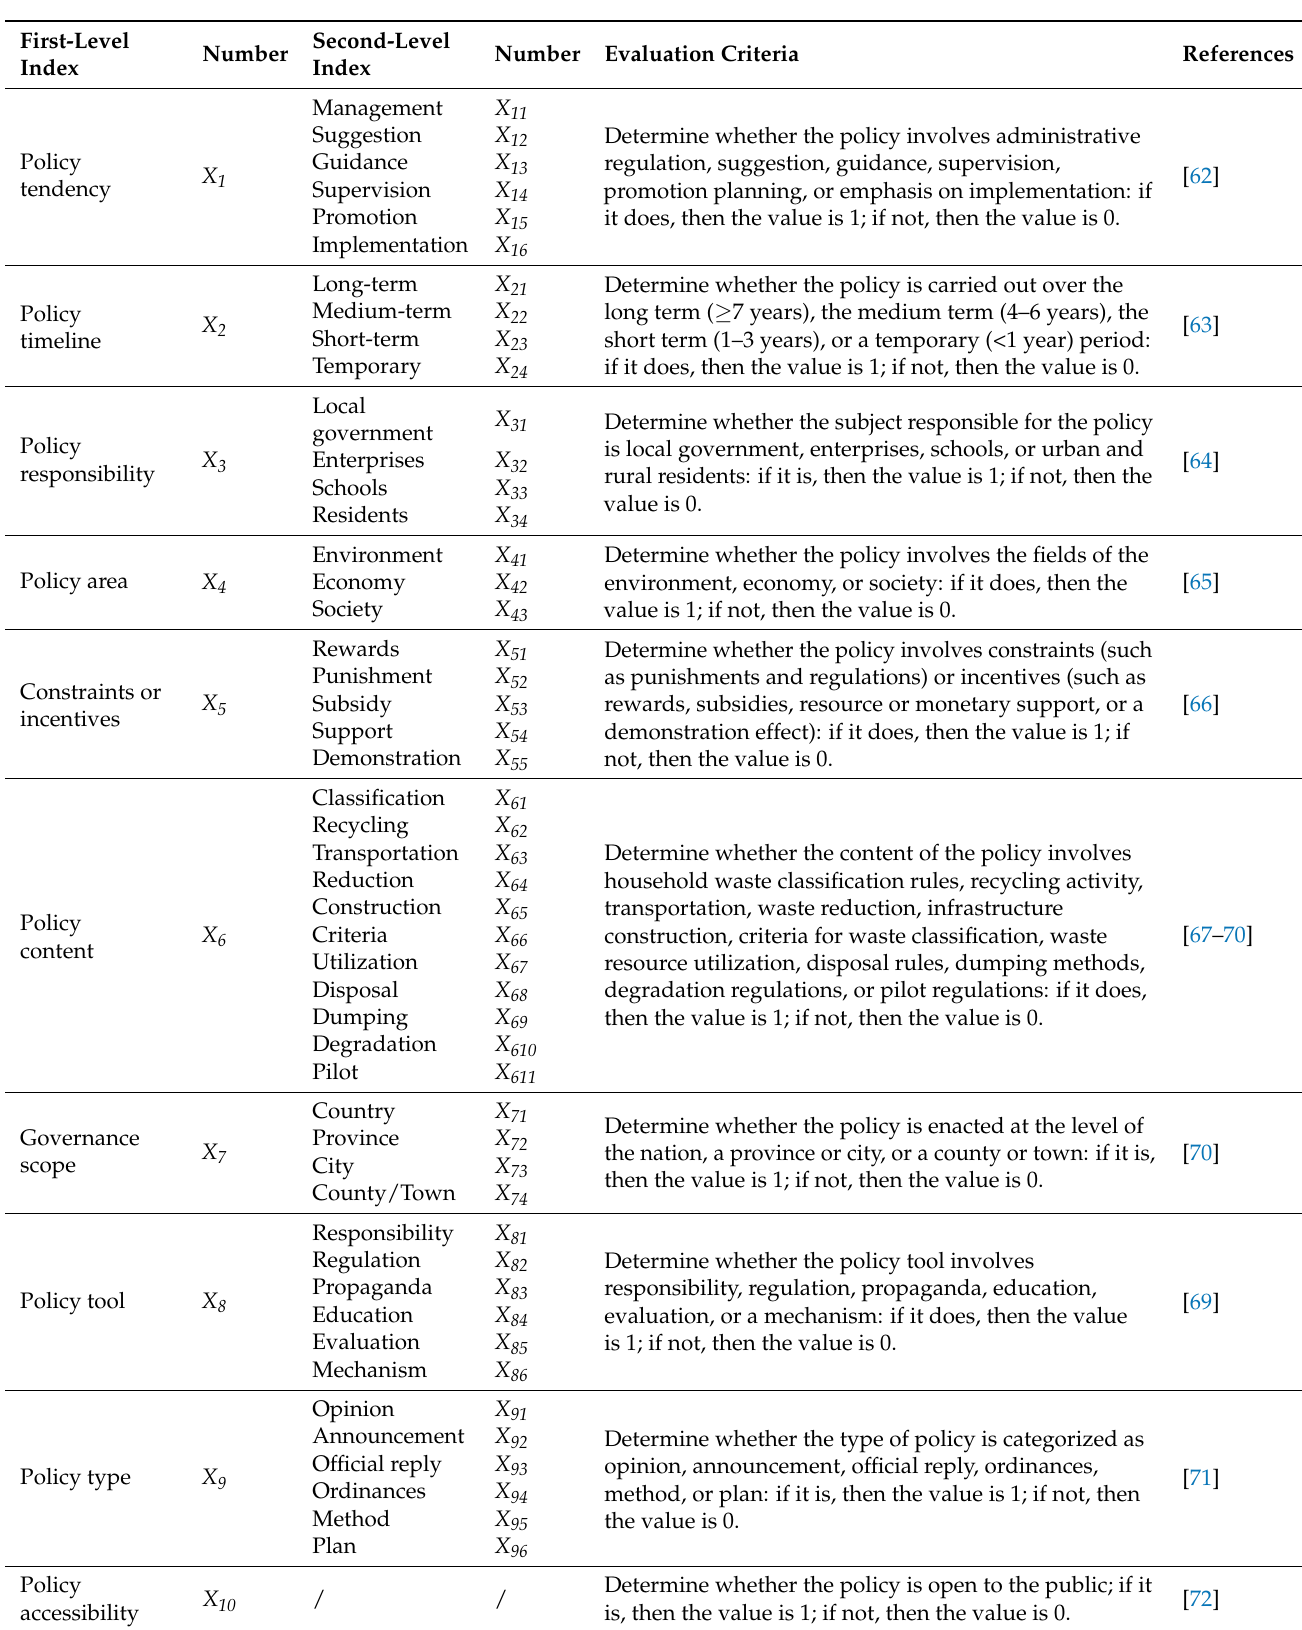
Table 2. Structure of the evaluation index system and criteria for the secondary